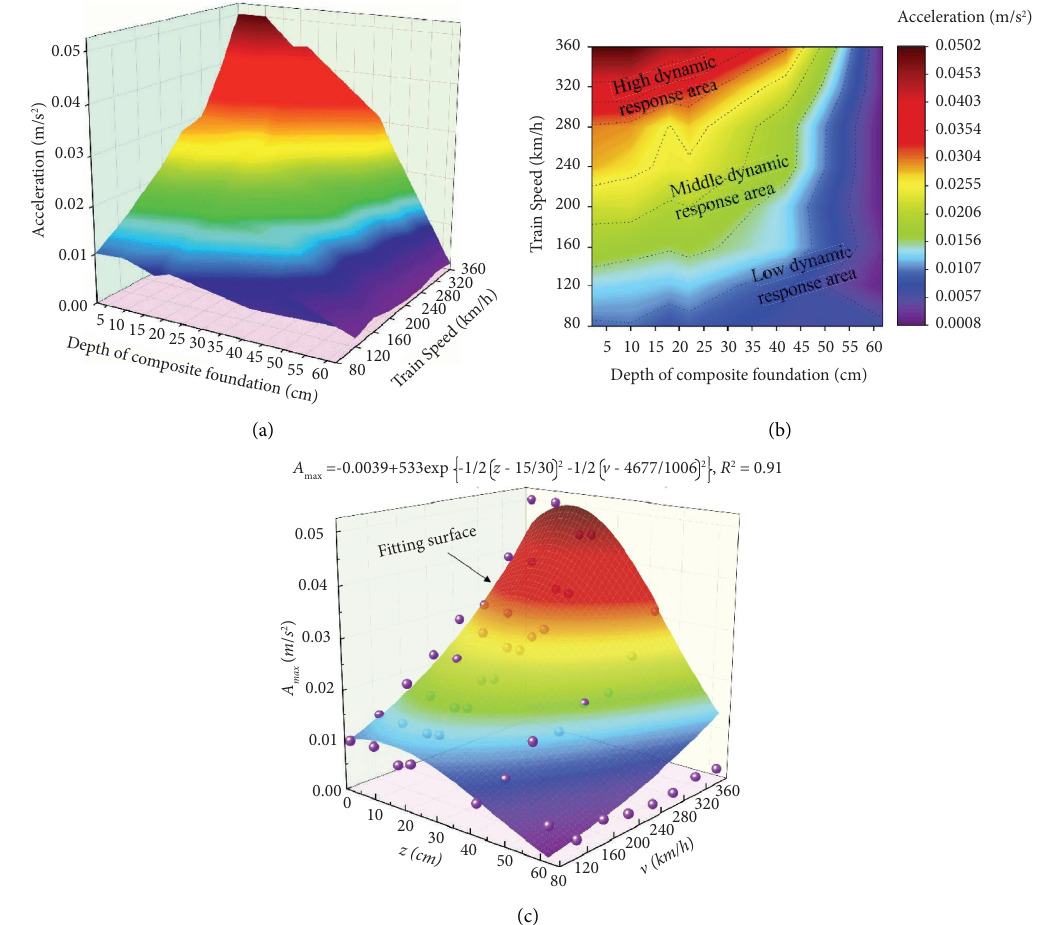
Figure 13: Temporal and spatial distribution of the acceleration response. (a) Tree-dimensional surface mapping of the peak acceleration response of PC-LSPCF with velocity and depth. (b) Te plane mapping of the peak acceleration response of PC-LSPCF with velocity and depth. (c) Te ftting surface of the peak acceleration response distribution of